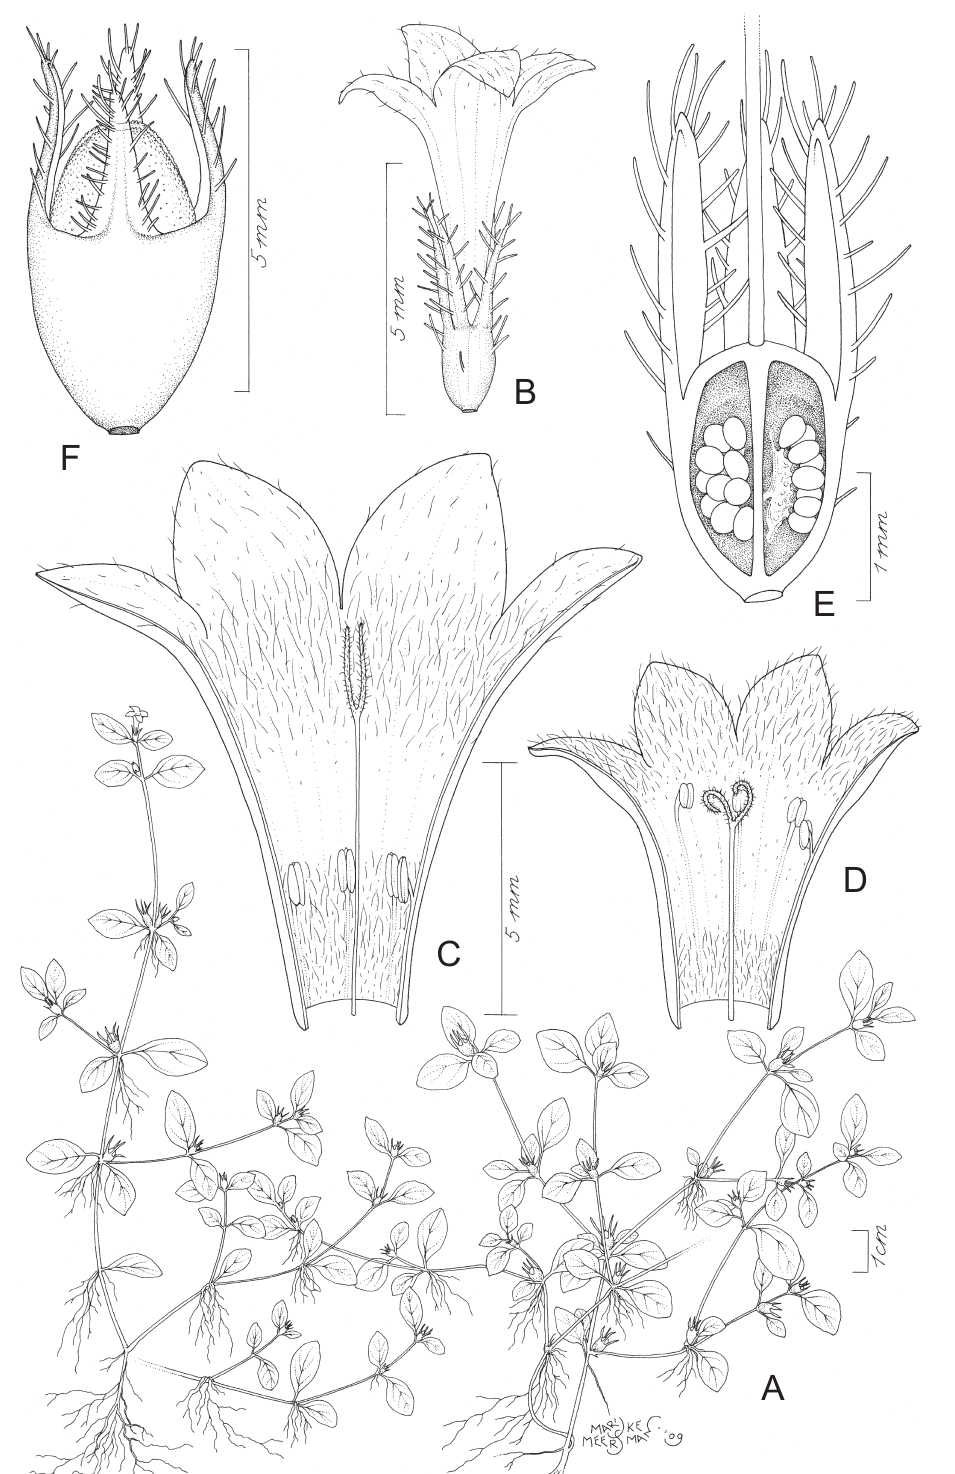
Fig. 12. Astiella latifolia Groeninckx sp. nov. A . Habit. B . Longistylous flower. C . Open longistylous flower. D . Open brevistylous flower. E . Ovary dissected to show placentation; some ovules removed from the right locule to show the shape of the placenta. F . Capsule. Drawn by Marijke Meersman. A, D–F from De Block et al. 2255 (BR); B–C from Baron 5214